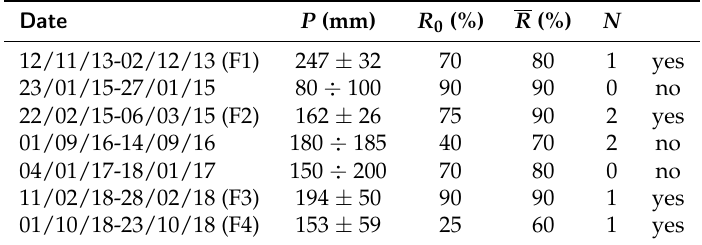
Table 3. Meteorological/hydrological values measured during the main precipitation events in the 2013–2018 period; P (mm) total cumulative precipitation (spatial average and standard deviation or estimated interval, see text), R 0 (%) initial relative volumetric soil moisture, R (%) time-averaged (over the whole event) value of the relative volumetric soil moisture R , N number of times the volumetric soil moisture reached the value corresponding to full saturation during the event, occurrence of flood.